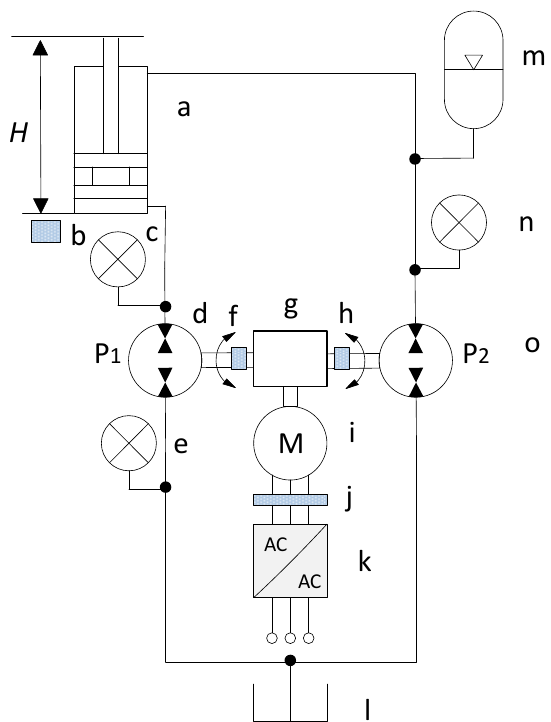
Figure 1. Simplified schematics of the test setup: (a) double-acting cylinder, (b) wire-actuated encoder, (c) pressure sensor, (d) reversible gear pump/motor P 1 , (e) pressure sensor in the tank line, (f) torque sensor, (g) T-gear, (h) torque sensor, (i) permanent magnet synchronous motor (PMSM) motor/generator, (j) current probes, (k) frequency converter and motor controller, (l) oil tank, (m) hydraulic accumulator, (n) pressure sensor, and (o) reversible gear pump/motor P 2 .